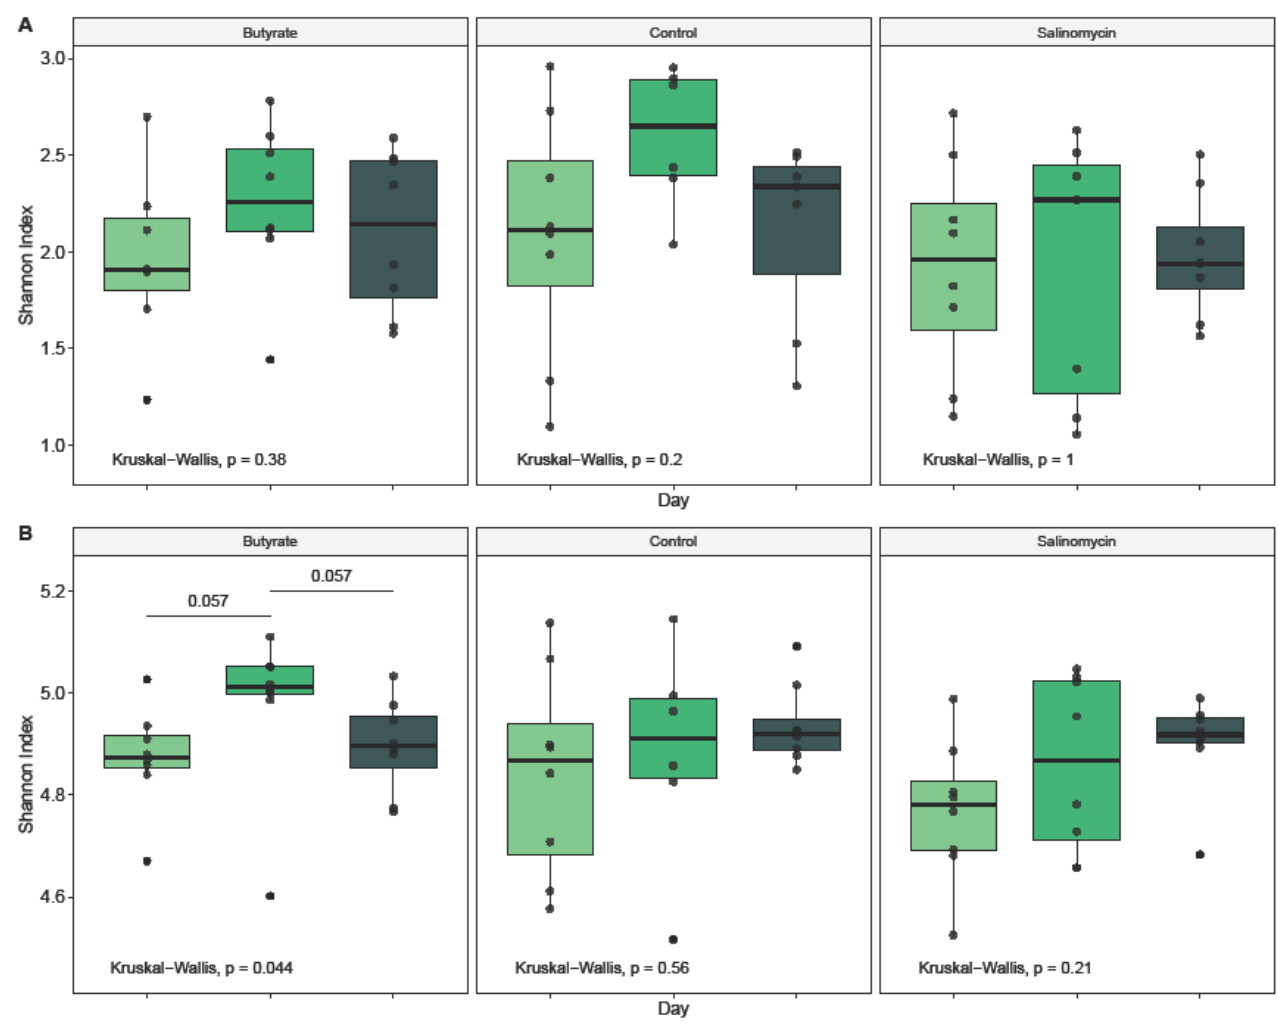
Figure 3. Broiler age effect on alpha diversity (Shannon Index) for ( A ) ileum and ( B ) ceca samples collected from chickens administered butyrate (UltraGuard™-DUO, 500 mg/kg), salinomycin (Sacox ® , 69 mg/kg), or no dietary supplement (control) and investigated for each treatment group separately. Overall age effects were identified using a Kruskal–Wallis test (provided in the bottom of each graph), and pairwise differences between age groups were determined by pairwise Wilcoxon rank sum tests (provided as horizontal bars with p value). Only significant pairwise differences are visualized.